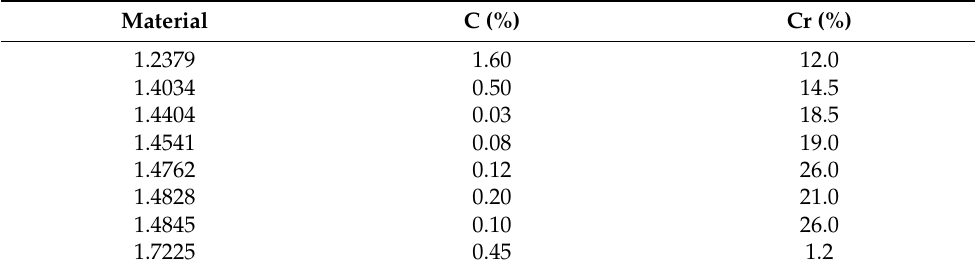
Table 14. Elemental concentration of carbon and chromium in selected